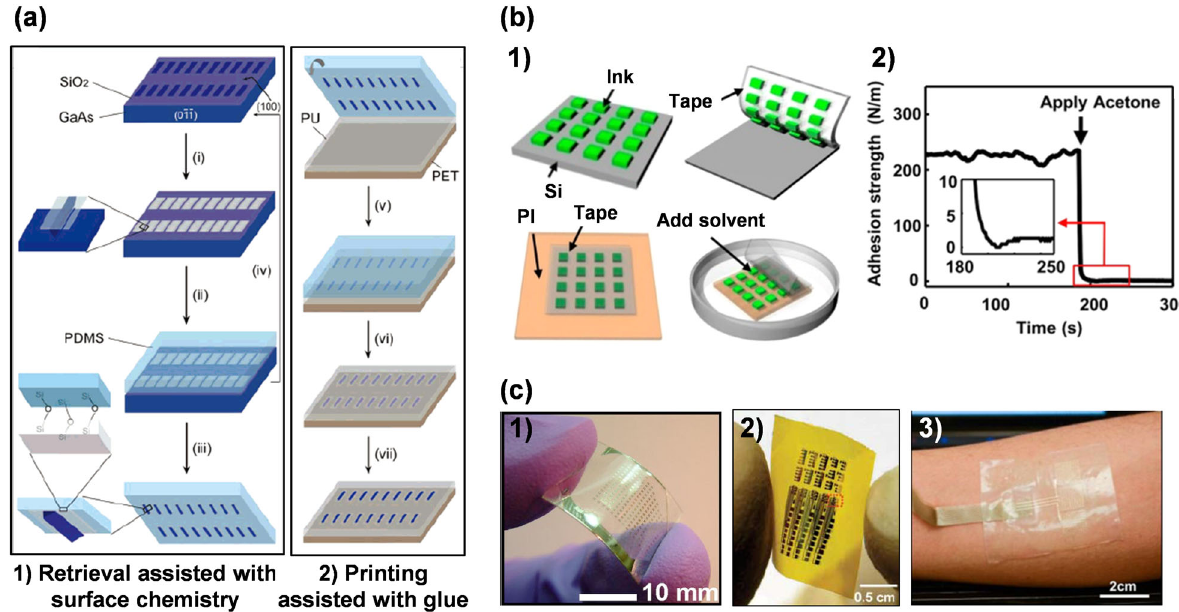
Fig. 3 Surface chemistry and glue assisted transfer printing techniques. a Schematic illustration of the transfer printing process of GaAs wire arrays onto plastic substrates. ( 1 ) Retrieval process utilizing the Si – O – Si chemical bonding between the surface of the slightly oxidized PDMS stamp and the fresh SiO 2 fi lm coated on the GaAs wire arrays. ( 2 ) The steps involved in the transfer process of GaAs wire arrays from PDMS stamp to PET sheet coated with a thin layer of PU. Reprinted with permissions from ref. 56 b Illustration of the transfer printing process of the solvent releasable tape and plot of measured adhesive strength of the 3M 3850 tape before and after introducing acetone under 180 o peeling test. Adapted with permission from ref. 66 c Devices and structures enabled by surface chemistry and glue assisted transfer printing techniques. ( 1 ) A high performance thin fi lm transistor built on a photosensitive epoxy coated PET substrate. Reprinted with permissions from ref. 60 ( 2 ) Array of 3D silicon n-channel metal oxide semiconductor inverters on a polyamic acid coated PI substrate. Reprinted with permissions from ref. 68 ( 3 ) An EMG sensor mounted on the skin of forearm for measurement enabled by solvent releasable tape. Reprinted with permissions from ref.